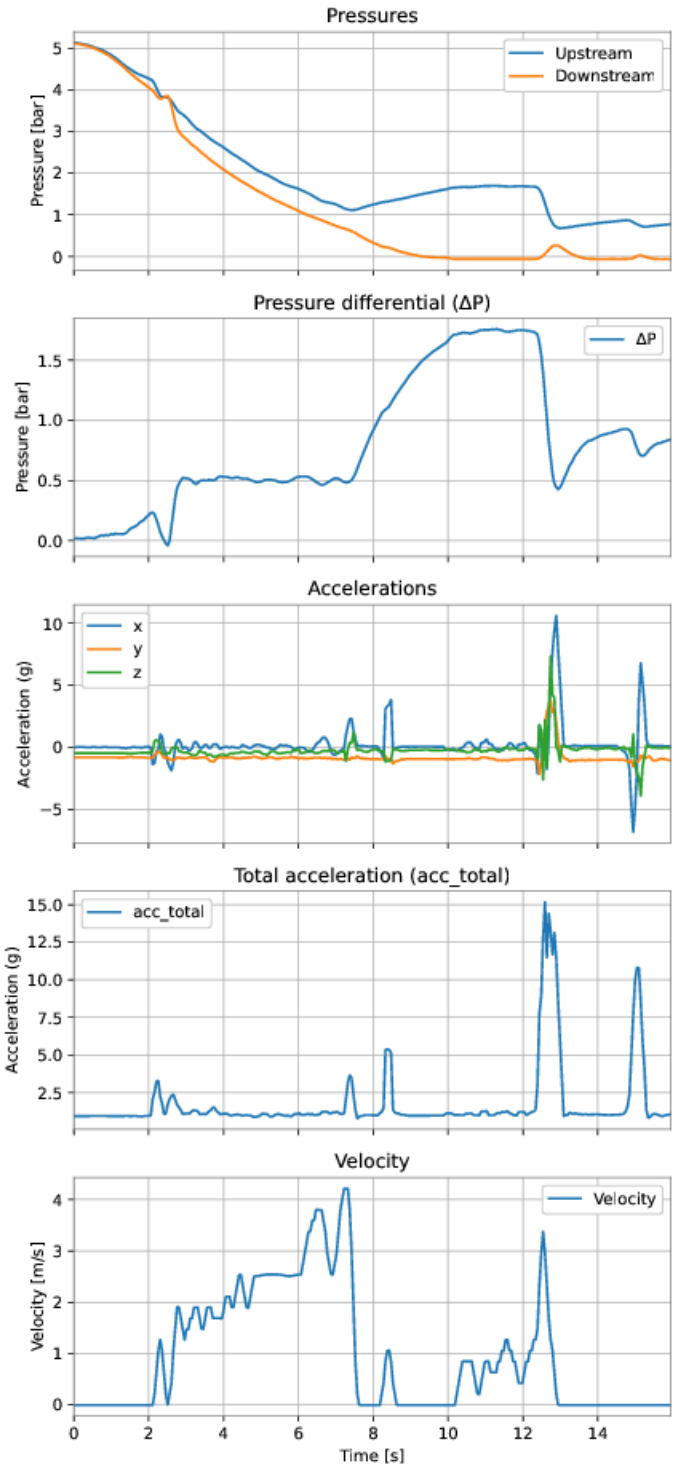
Figure 41. Training dataset. After instant 14 s, it is possible to see a probable inconsistency in the velocity measurement, since the differential pressure and the accelerations varied significantly while the velocity remained